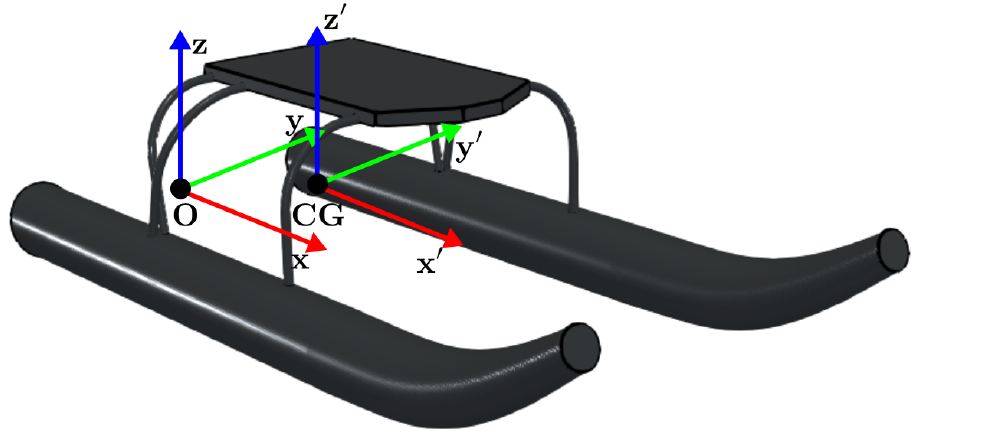
Figure 1. The coordinate system of WAM-V 16.